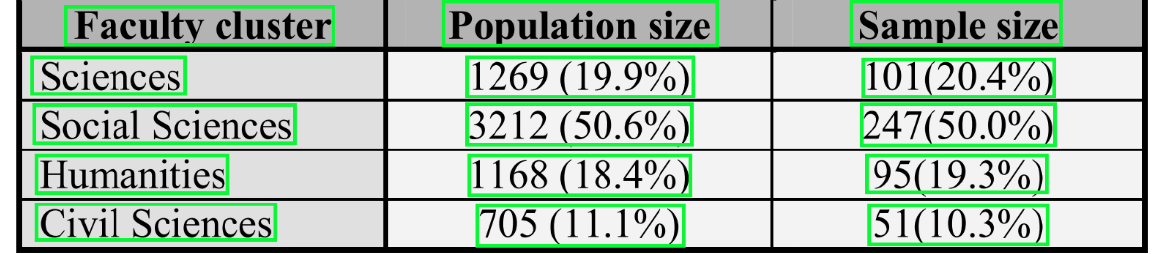
Figure 7. Text box callout visualization.